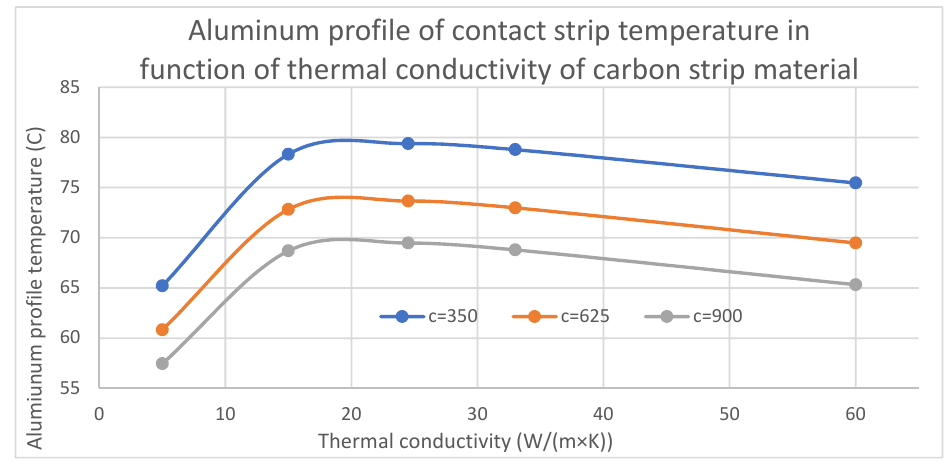
Figure 17. Contact wire temperature as a function of thermal conductivity of carbon strip material. The increase in temperatures in the tested system also affects the relative deformations of contact strip. The comparison of the obtained relative deformations is included in Table 7 and illustrated in Figure 18.